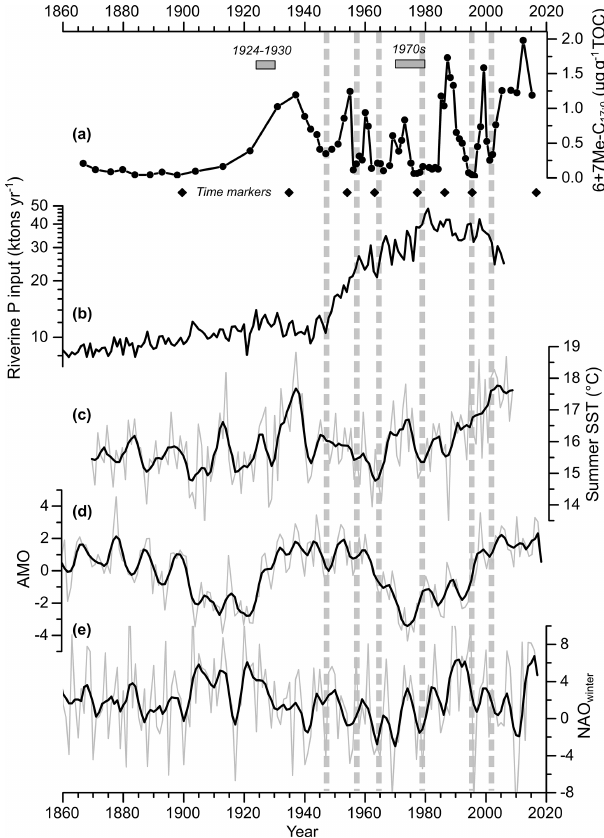
Figure 5. Core MSM51-2/20 record of the sum of 6Me-C 17 : 0 and 7Me-C 17 : 0 (6 + 7Me-C 17 : 0 ) normalized to TOC (line with dots) (a) , annual riverine phosphorus input to the Baltic Sea (Gustafsson et al., 2012) (b) , summer (July–August) HadISST1 (Rayner et al., 2003) sea surface temperature (SST) for the Baltic Sea (c) , the Atlantic Multi-decadal Oscillation index (AMO; En- field et al., 2001; https://www.esrl.noaa.gov/psd/data/timeseries/ AMO/, last access: 1 October 2019) (d) , and the winter (DJFM) North Atlantic Oscillation index (NAO; Hurrell, 1995; Jones et al., 1997; https://www.esrl.noaa.gov/psd/gcos_wgsp/Timeseries/NAO/, last access: 1 October 2019) (e) . Both raw (light grey) and five- point adjacent averaged (black line) data are shown. The diamonds represent the age control points of core MSM51-2/20 (Fig. 2; Ta- ble S2). The horizontal grey rectangles represent two periods with relatively high cyanobacterial blooms as inferred from historical records (Finni et al., 2001). The vertical dashed lines highlight the periods with low 6 + 7Me-C 17 : 0 content. The data are listed in Ta- ble